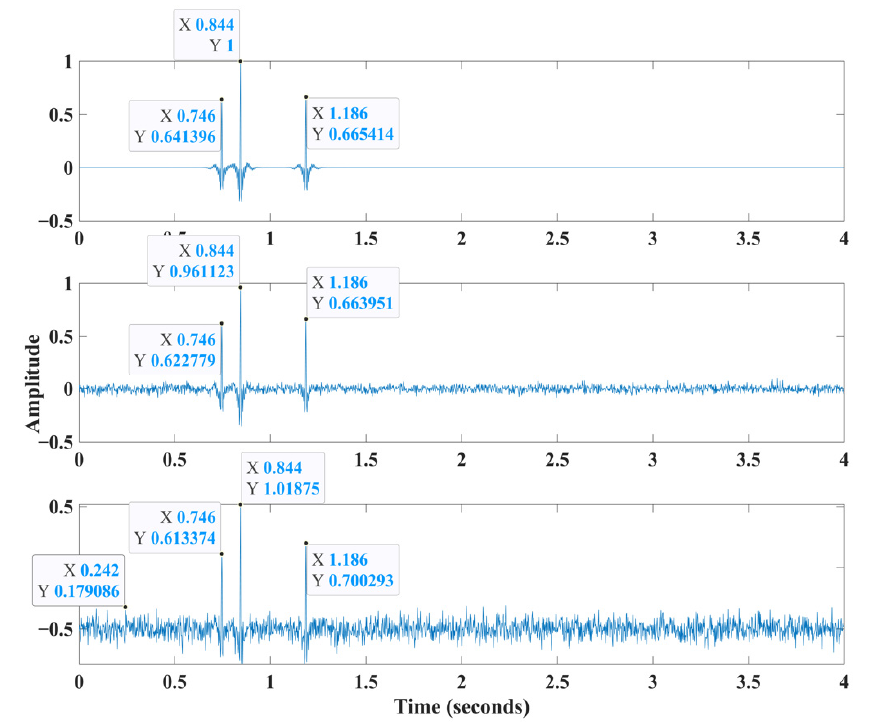
Figure 4. Clean synthetic data example trace number 20 ( top ) with the location of the first and later arrivals indicated. After adding 10% noise to the same synthetic trace ( center ). After adding 20% noise to the same synthetic trace ( bottom ).